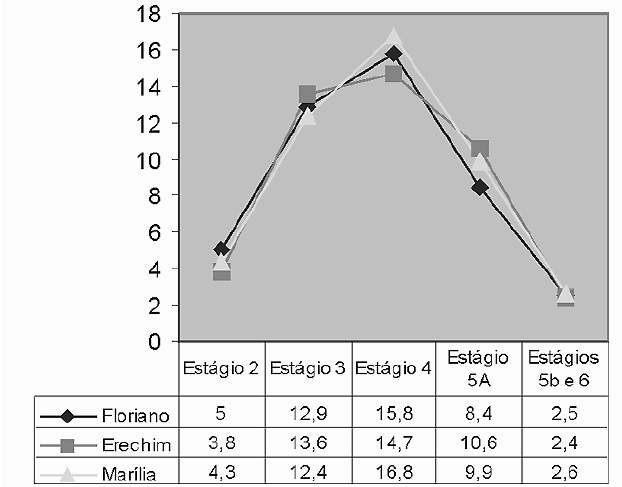
Figura 6. Pontua(cid:231)ªo mØdia bruta dos jovens brasileiros de Floriano/PI, Erechim/RS e Mar(cid:237)lia/SP no